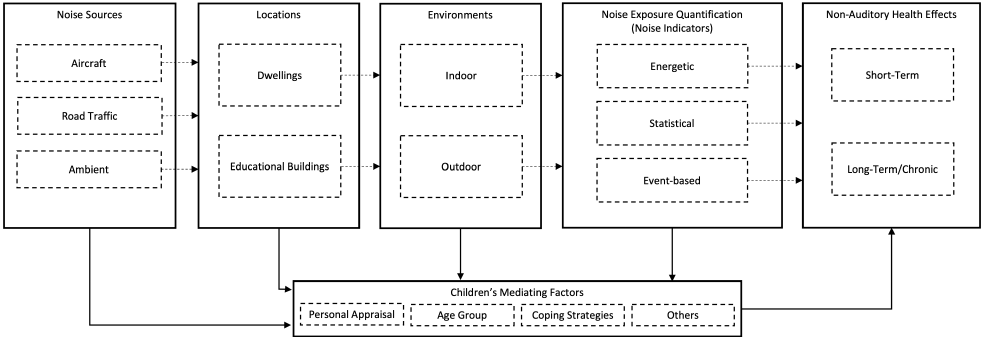
Figure 2. Conceptual framework of the relationship between noise exposure and non-auditory health effects in